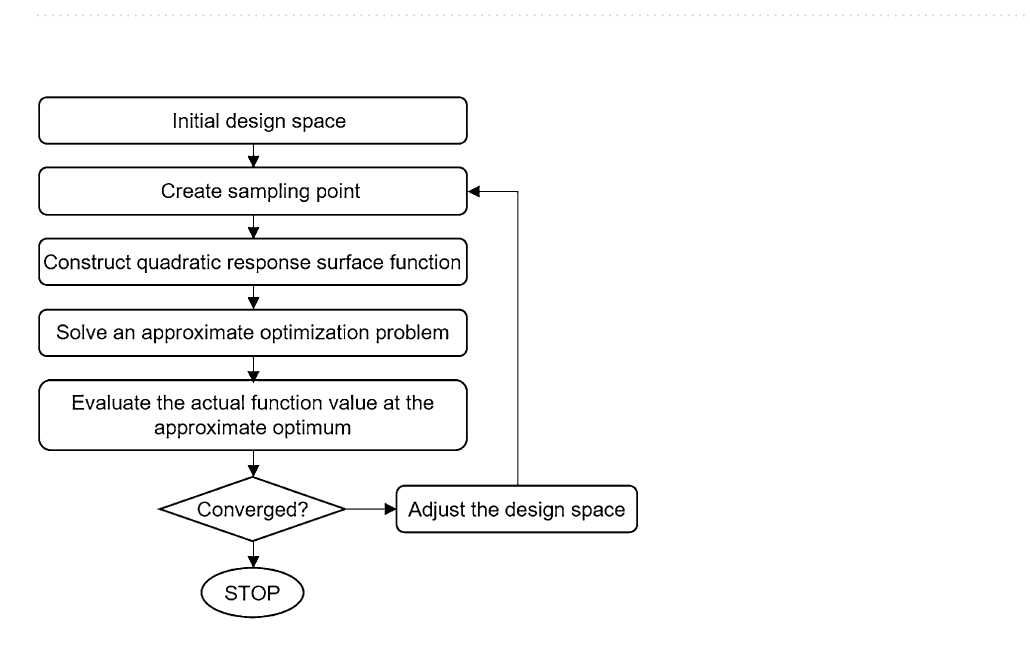
Figure 5. Flowchart of the PQRSM optimization